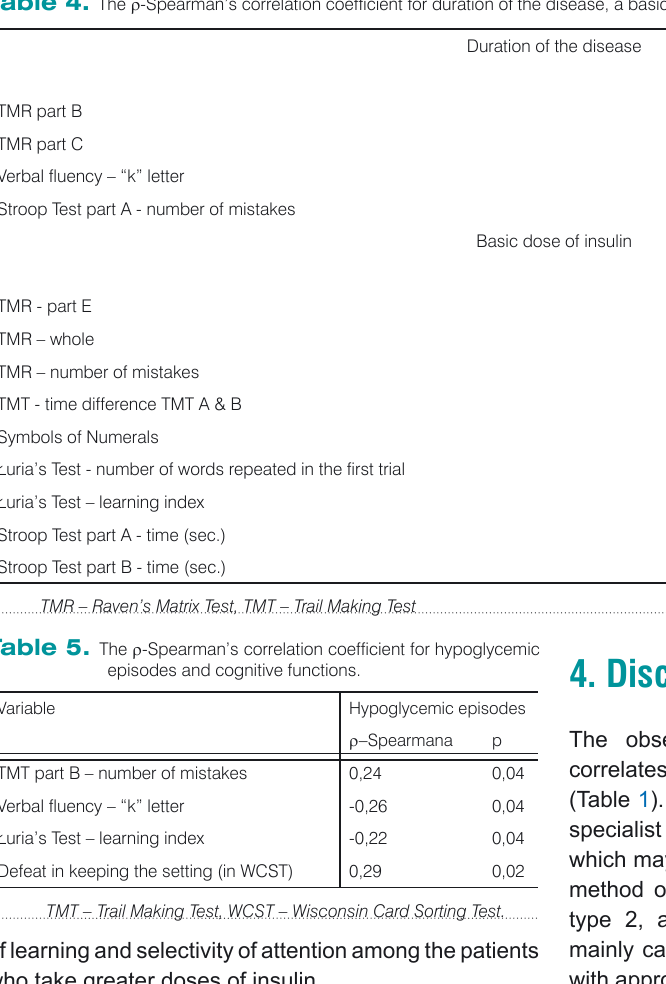
Table 4. The ρ -Spearman’s correlation coefficient for duration of the disease, a basic dose of insulin and cognitive functions.